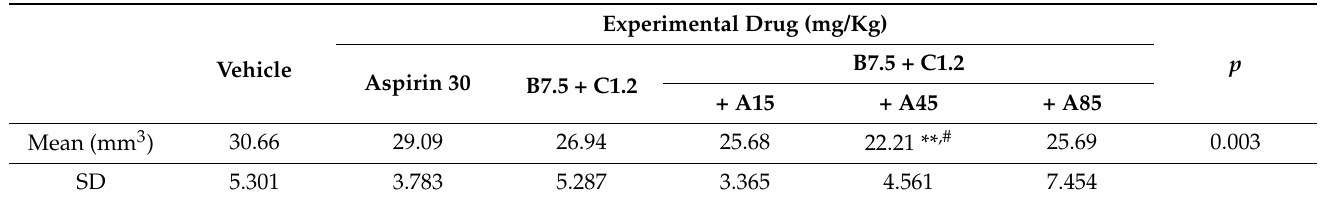
Table 8. Effects of Sample A + B + C on infarct volume after pMCAO ( n = 8–10 mice for each group).